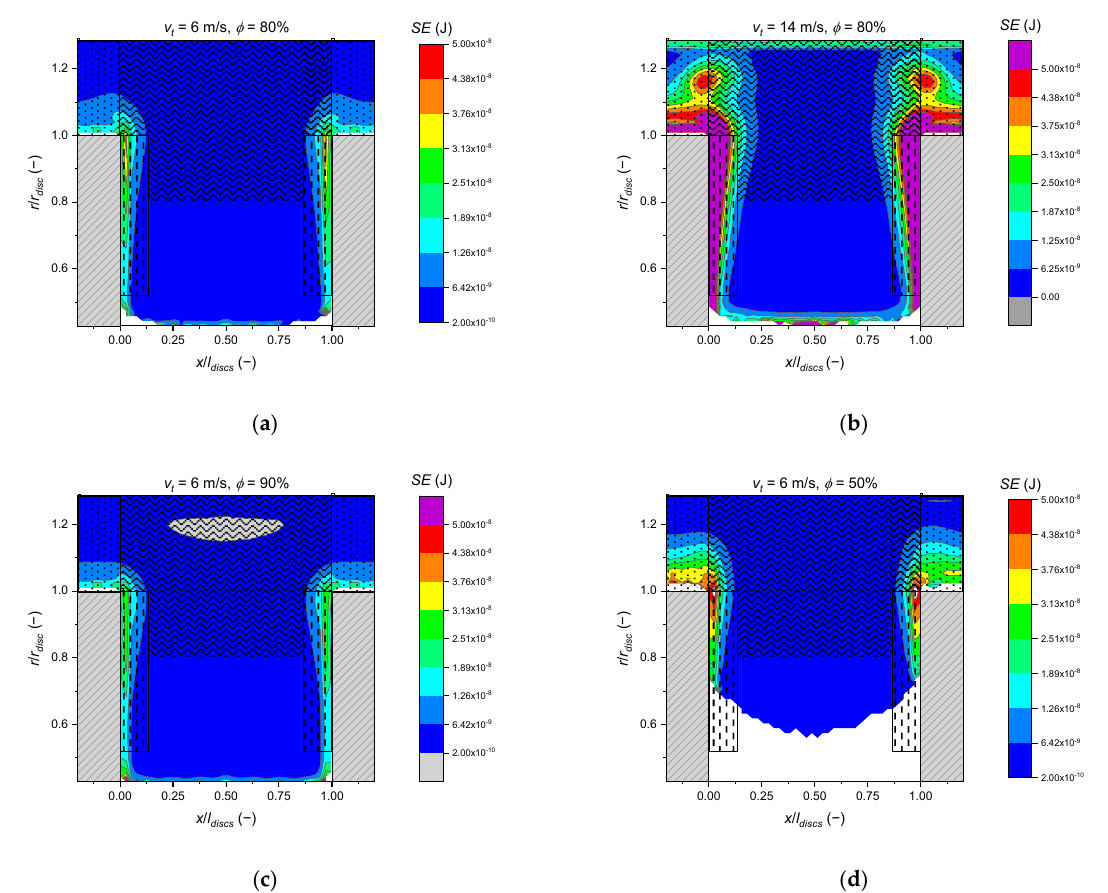
Figure 12. Radially averaged local stress energy on a linear color scale with the dimensions of the volumes marked as follows: V1, dots; V2, dashes; V3, saw-toothed. ( a ) Stirrer tip speed of 6 m/s and grinding media filling of 80%; ( b ) stirrer tip speed of 14 m/s and grinding media filling of 80%; ( c ) stirrer tip speed of 6 m/s and grinding media filling of 90%; ( d ) stirrer tip speed of 6 m/s and grinding media filling of 50%.